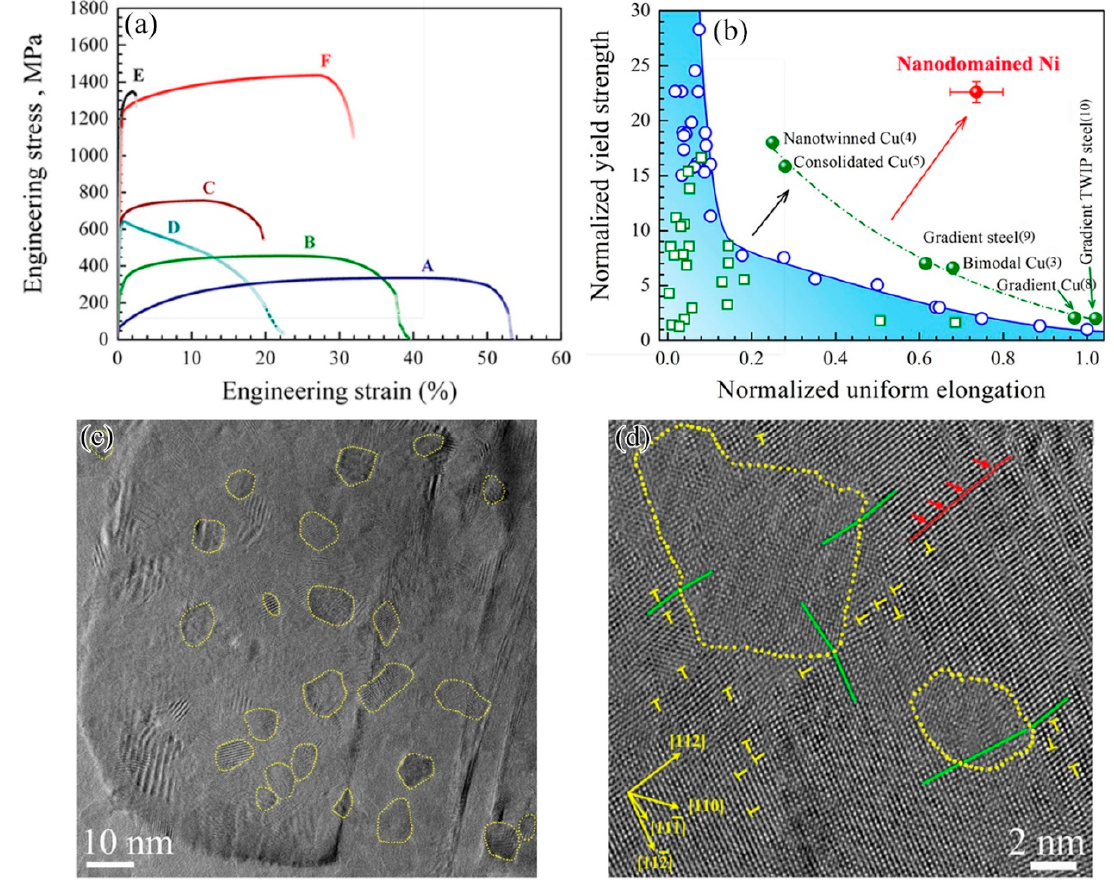
Figure 15. ( a ) Engineering tensile stress–strain curves at a strain rate of 4 × 10 − 4 s − 1 : Curve A: as-annealed CG Ni with an average grain size of 27 µ m; Curve B: electrodeposited (ED) Ni ( d = 1 µ m); Curve C: electrodeposited UFG Ni ( d = 200 nm); Curve D: UFG Ni obtained via equal channel angular pressing (ECAP) for one pass; Curve E: ED nanocrystalline Ni ( d = 18 nm); Curve F: electroplated nanodomained Ni ( d = 150 nm, d domain = 7 nm). ( b ) Normalized yield strength versus normalized tensile uniform elongation for metals. ( c ) TEM images of nanodomained Ni, showing low-angle domain boundaries (LADBs). ( d ) High-resolution electron microscope (HREM) images showing the dislocation pile-ups. (adapted from [119]).